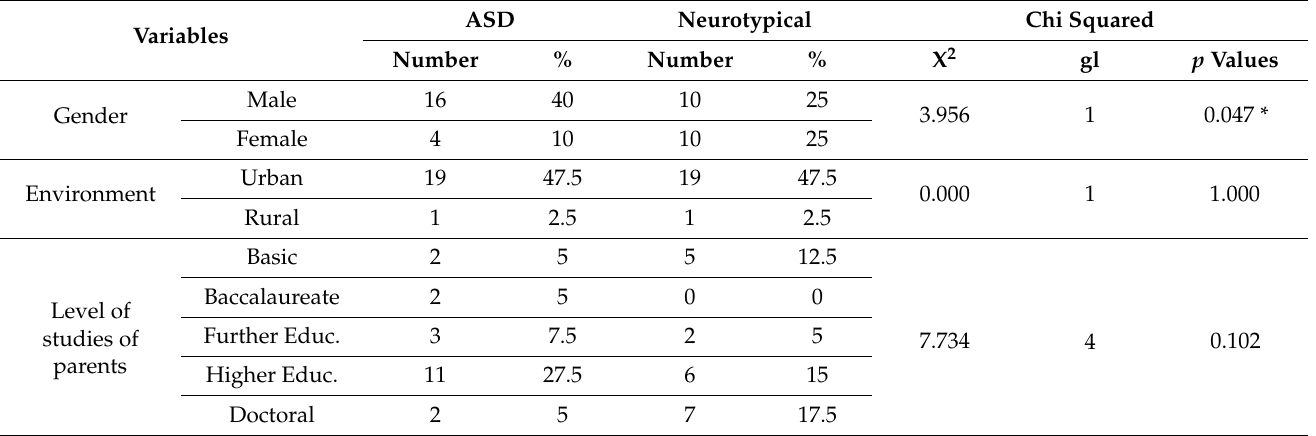
Table 2. Data relating to the analysis of the qualitative variables of both groups.